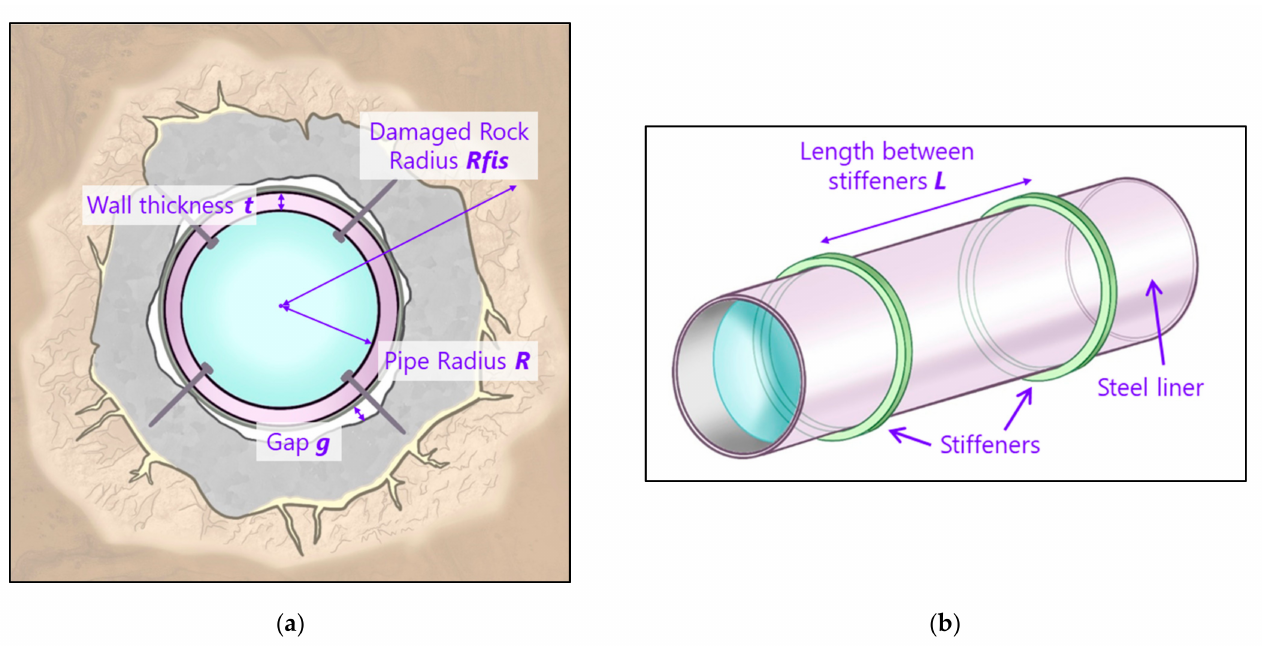
Figure 2. Main variables in a liner ( a ) section and ( b ) longitudinal